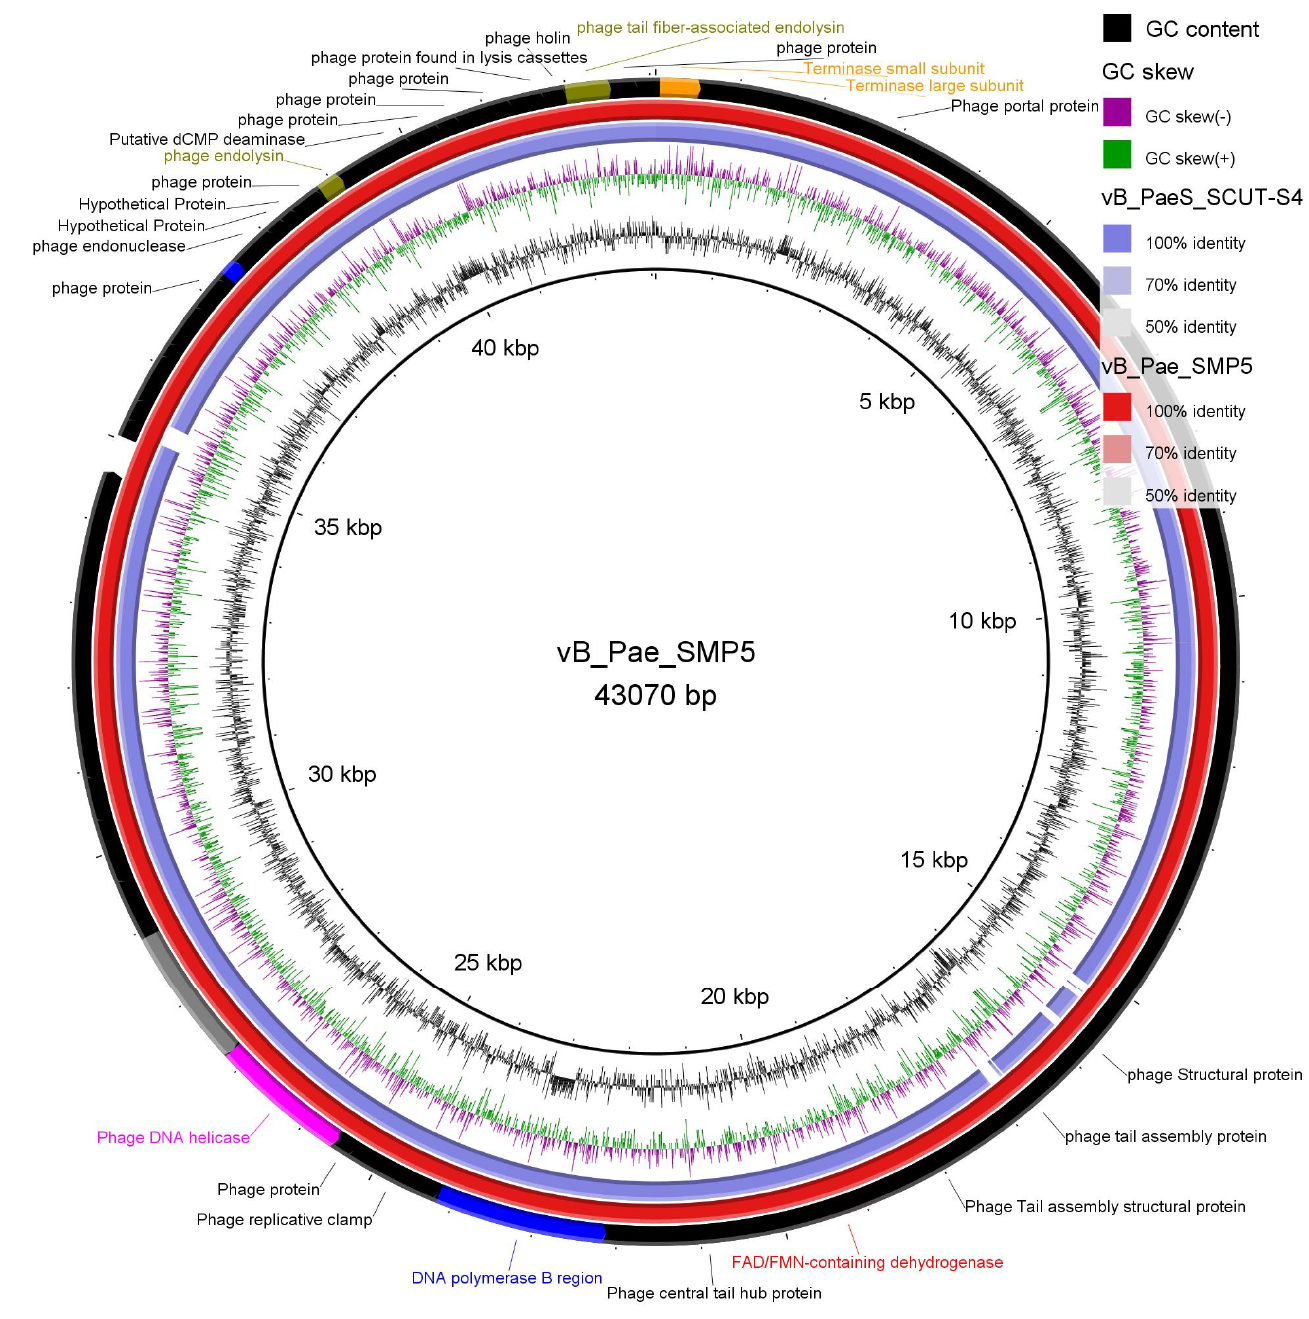
Figure 2. Circular genome map of vB_Pae_SMP5 (Red ring). The BV-BRC accession is 2731619.92. The color coding of genes indicates the functional categories of putative proteins: phage and hypothetical proteins (Black), terminase protein (orange); phage helicase (fuchsia); regulatory protein (purple); phage endolysin (olive); Phage polymerase (blue); exonuclease (Gray); blue ring is the reference phage Pseudomonas phage vB_PaeS_SCUT-S4 (NCBI nucleotide accession code MK165658.1). The creation of the circular image and comparison with other reported similar plasmids were performed using the BLAST Ring Image Generator (BRIG) tool v0.95 (https://sourceforge.net/projects/brig/, accessed on 25 October 2022).